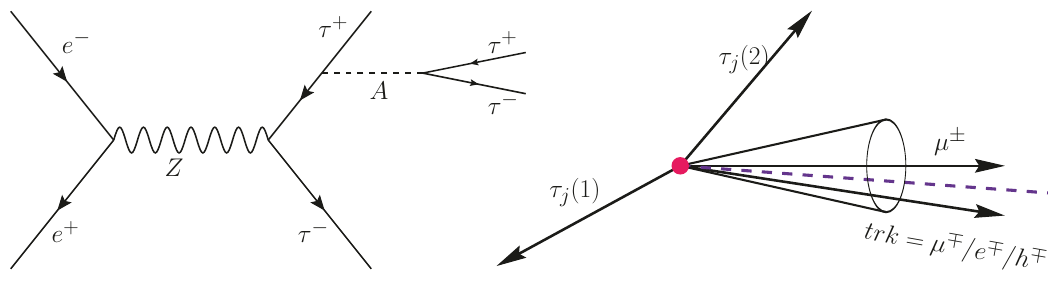
Figure 1 . Signal topology of a light boson production at the lepton collider. The dashed line in the right panel depicts the direction of light boson φ